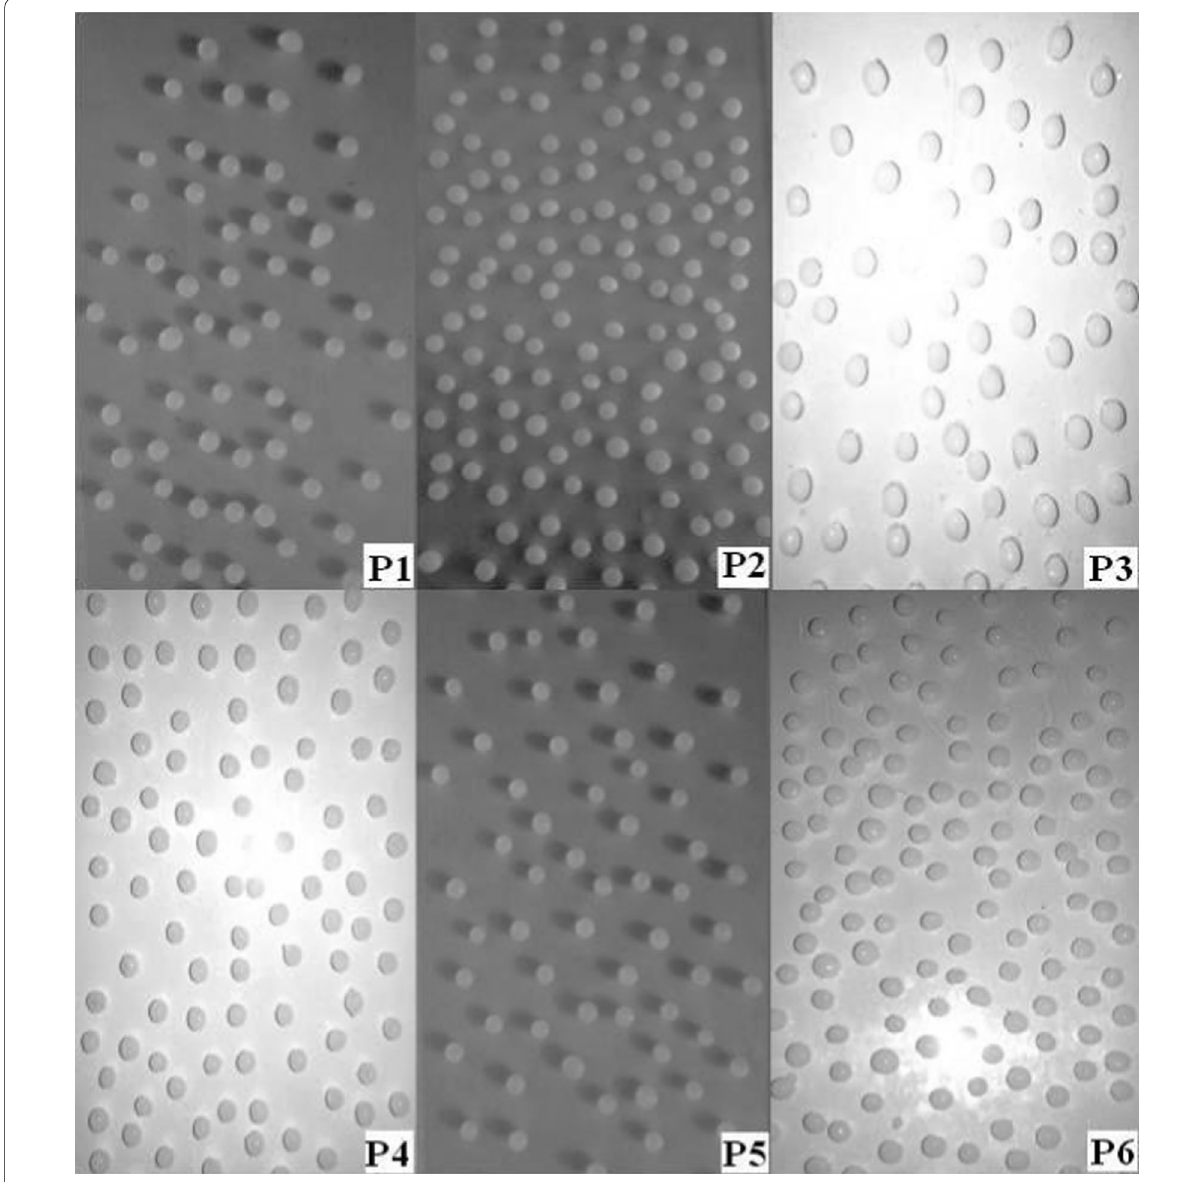
Fig. 3 Photographs of all these Chitosan–Gellan Gum–Gum Ghatti and -Gum Karaya PEC beads containing diclofenac sodium ( P1 to P6